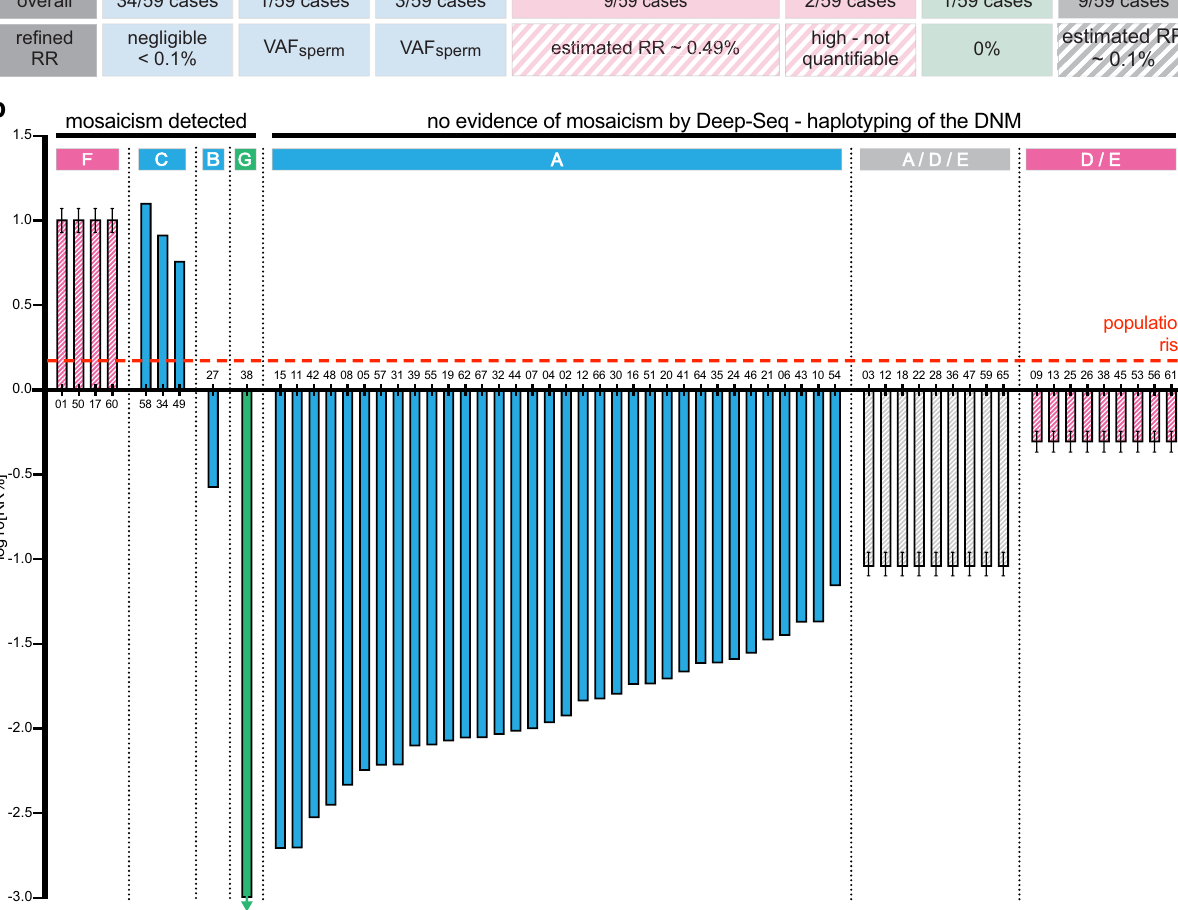
DNMs of paternal (Categories A – C, via semen analysis, blue) and post-zygotic (Category G, green) origin (represented by block colours); note that to be con- servativeinourestimatesofRR,theplottedbarsrepresenttheupper95%binomial CIfromthecorrectedVAFmeasuredinspermsamplesbyDeep-NGSforeachofthe paternally-derivedDNMs(SupplementaryData2).TheRRcanonlybeestimatedfor maternal (pink) or haplotype-unresolved cases (grey). These estimates are repre- sented by stripes, with error bars representing the upper and lower 95% CI — see Supplementary Note 6 for details on estimate calculations. Note that the DNM of FAM54 was analyzed by allele-speci fi c PCR (Supplementary Note 2) and that CategoryF includes the twoadditionalfamilies with multiple affected pregnancies (FAM17 and